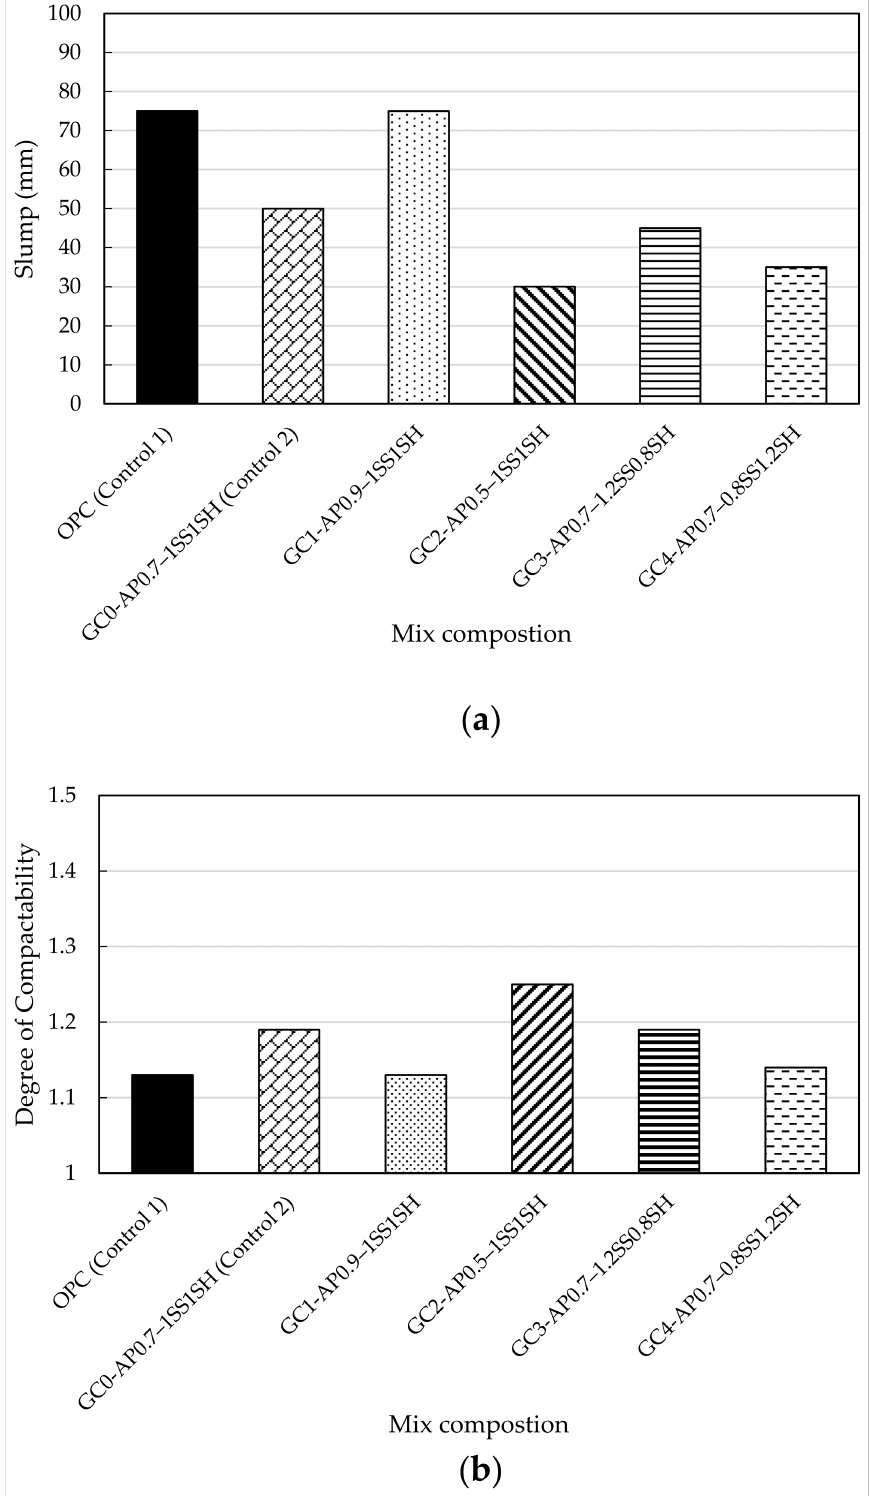
Figure 3. Consistency of concrete mixes measured by ( a ) slump and ( b ) the degree of compact- ability